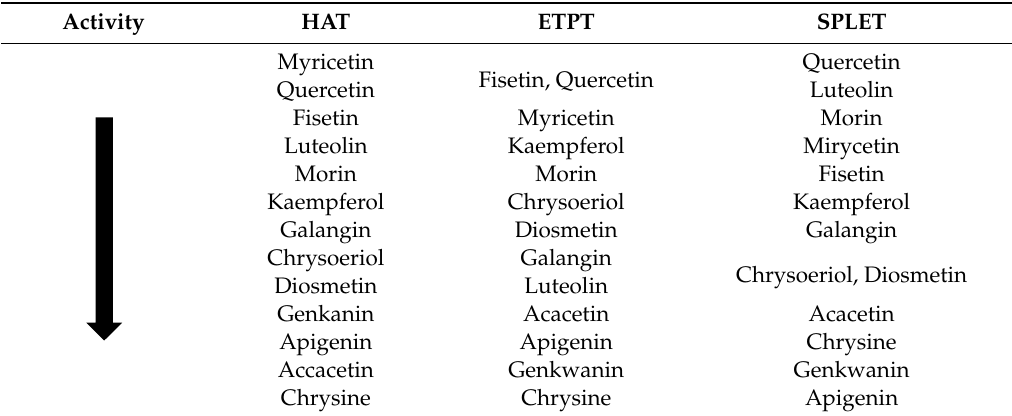
Table 7. Relative activity of investigated compounds.